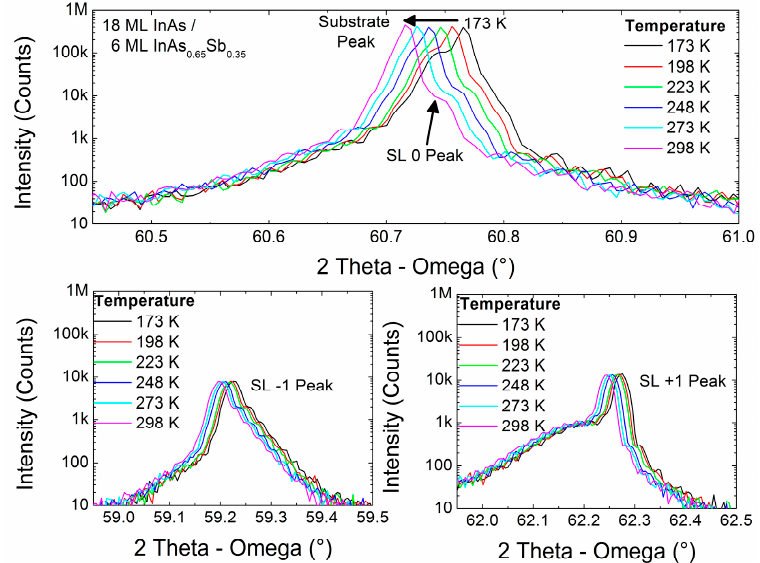
Figure 1. (Upper frame) X-ray diffraction (XRD) scans of the substrate and InAs/InAsSb SL 0 peak from 173–298 K. The substrate and superlattice have approximately the same average out-of-plane lattice constant. (Lower left frame) The SL − 1 peak of the superlattice. Pendellösung fringes are evident across temperature. (Lower right frame) The SL +1 peak of the superlattice. The peak behaves similarly to the SL − 1 peak.